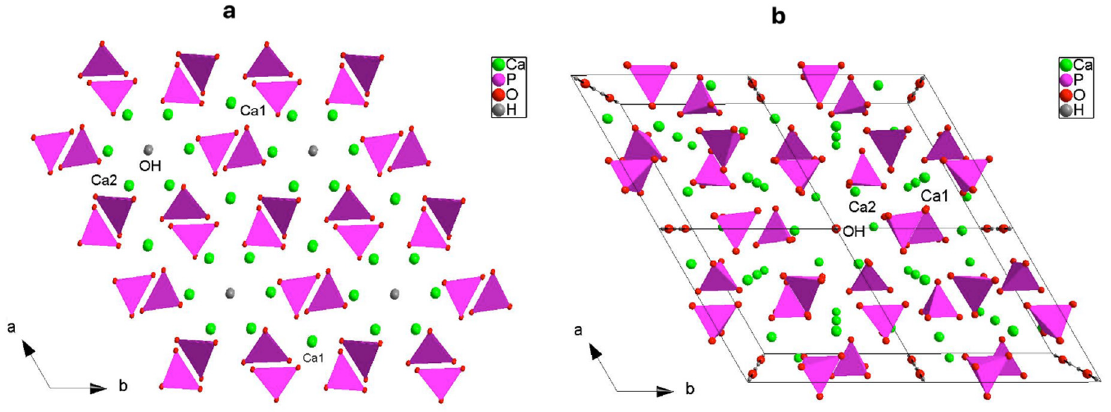
Figure 3. Representation, down c , of the three-dimensional framework of HAp: ( a ) detail of the hexagonal tunnel, and ( b ) clinographic view of the supercell 2 × 2 (b).